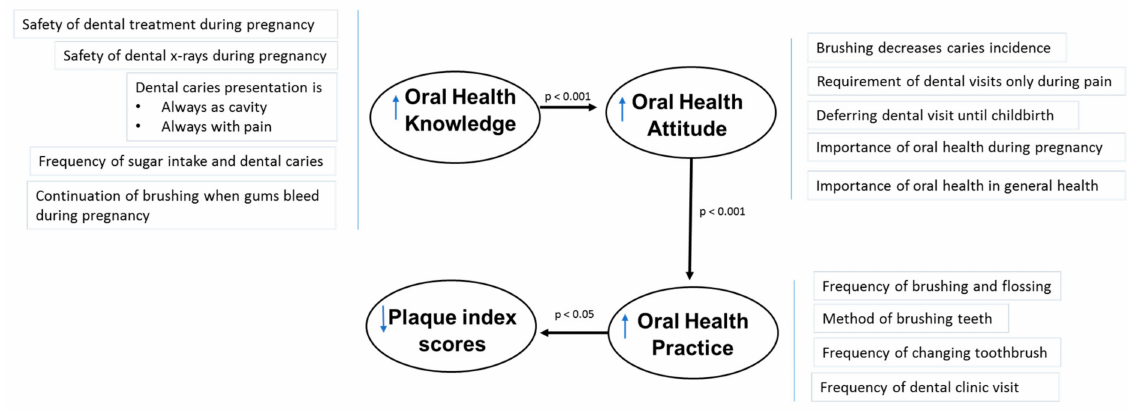
Figure 2. Correlation between the oral health determinant